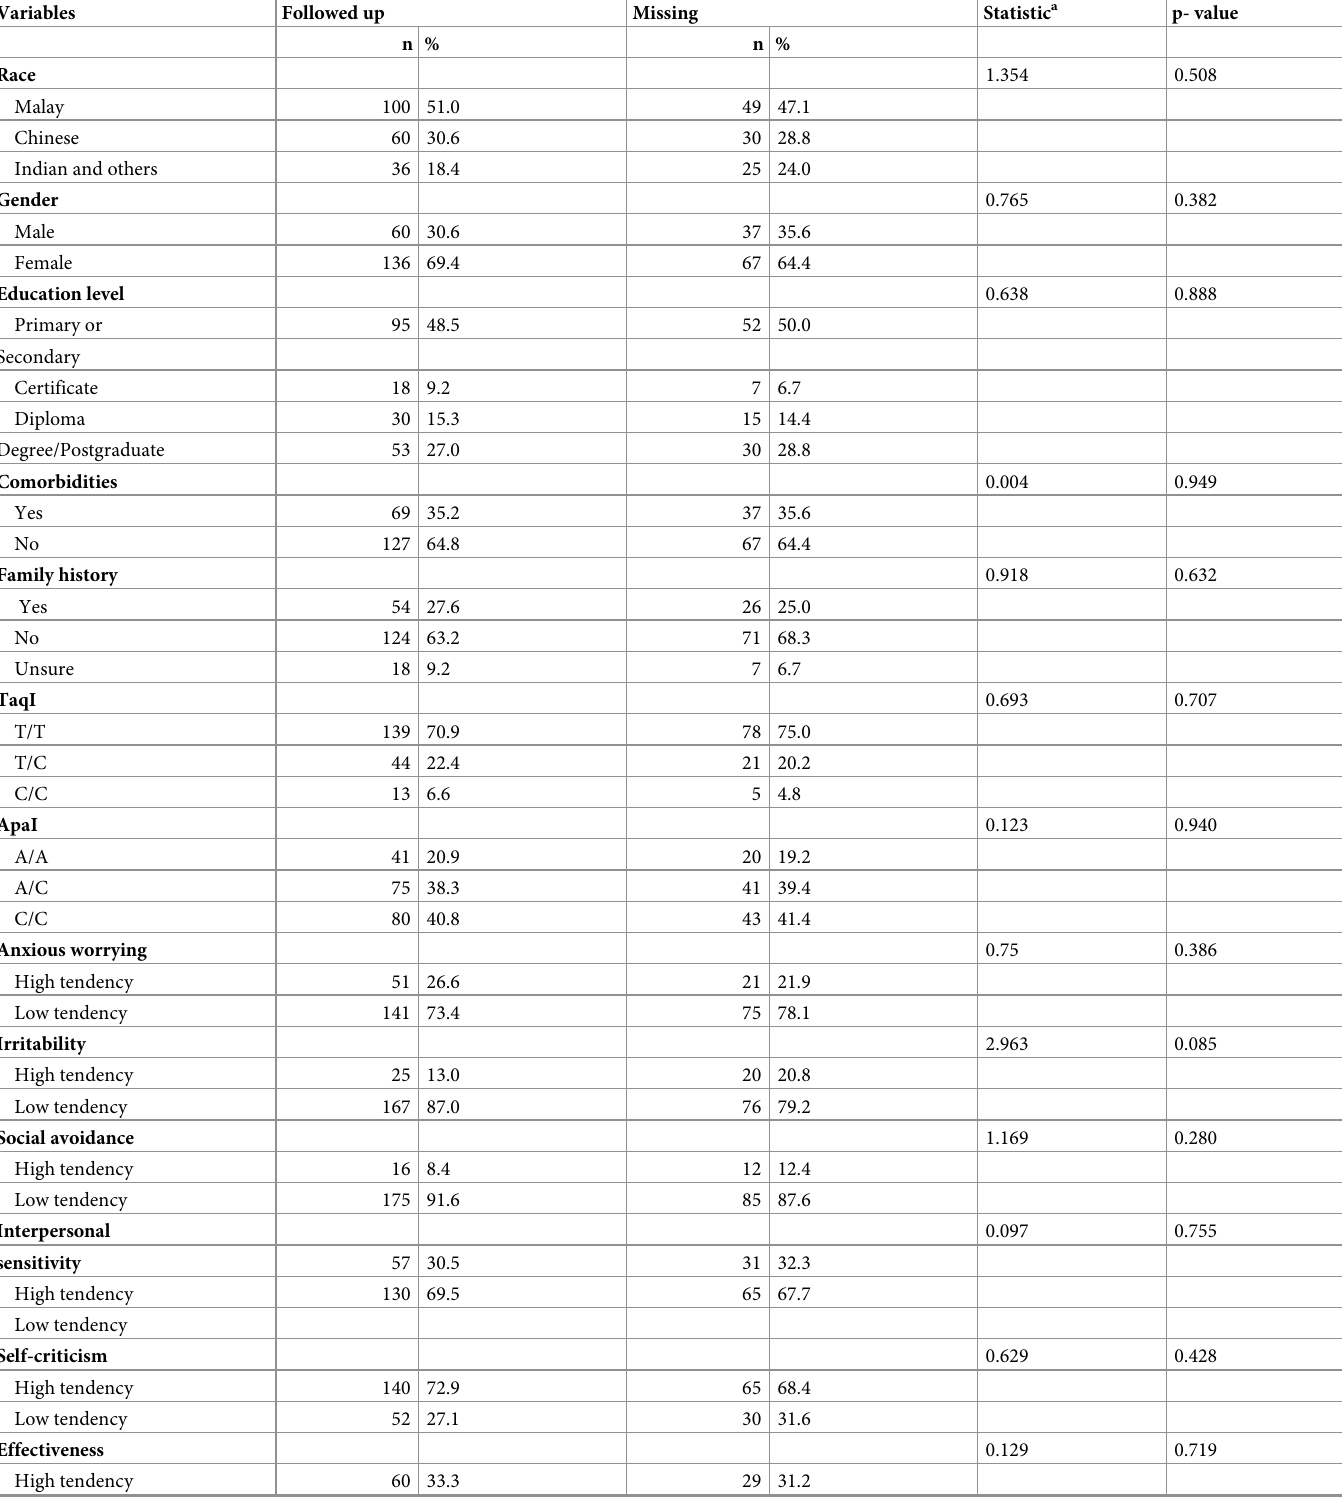
Table 1. Comparison of cases included for analysis versus missing